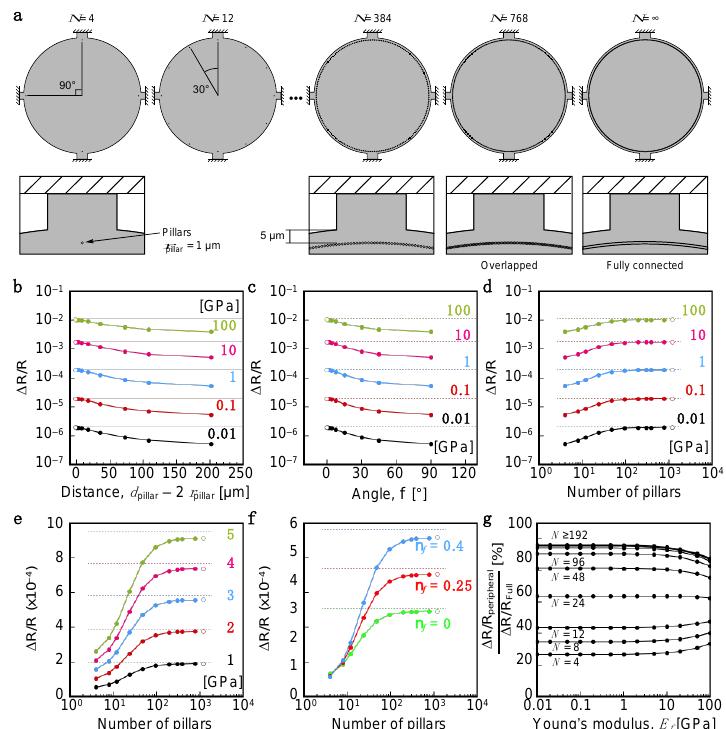
Figure 4. Dependence of the relative resistance change ( ∆ R / R | total ) on the distance of the interfacial attachments ( d pillar ) calculated by FEA. ( a ) Configuration of pillars as a model of interfacial attachment. The radius of pillars ( r pillar ) is fixed at 1 µm. Each piezoresistor-integrated sensing beam is magnified in the bottom insets. ( b – d ) The Young’s modulus-dependent total resistance change ∆ R / R | total on the distance ( b ), area ( c ) and number ( d ) of the pillars. Details are listed in Table 3. The Young’s moduli are varied in the range of 0.01 GPa to 100 GPa. ( e ) Dependence of ∆ R / R | total as a function of the number of pillars. E f = 1–5 [GPa]. Poisson’s ratio of a coating film ( ν f ) is 0.4. ( f ) The Poisson’s ratio-dependent total resistance change ( ∆ R / R | total ) as a function of the position of pillars ( r pos. ). The Young’s modulus of coating film is 3.0 GPa, which is similar to that of PMMA. Closed and open circles are ∆ R / R | total on d pillar and fully attached model, respectively. Dotted lines in ( b )–( f ) are ∆ R / R | total of the fully attached model. ( g ) Relative sensing responses compared to ∆ R / R | total of the fully attached model. Table 3. Detailed parameters of the model in Figure 4.